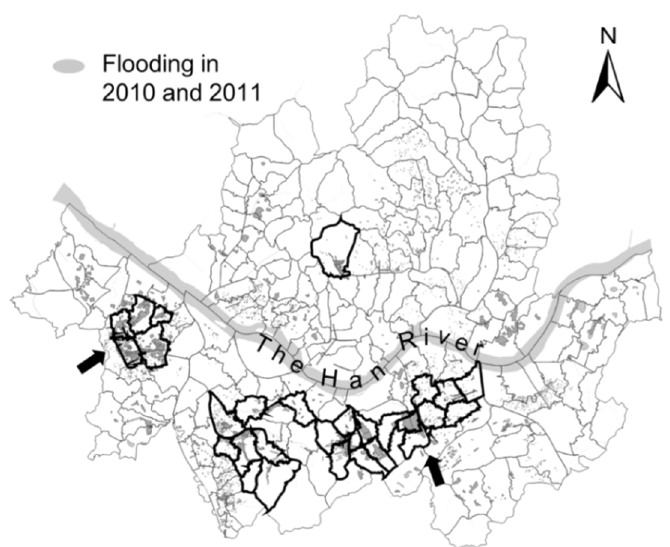
Figure 3. Test catchments in Seoul: the black-lined catchments were selected to estimate the value of β ; flood damages in 2010 and 2011 primarily occurred in the southwestern areas (Shinweol) and also southeastern areas (Gangnam).